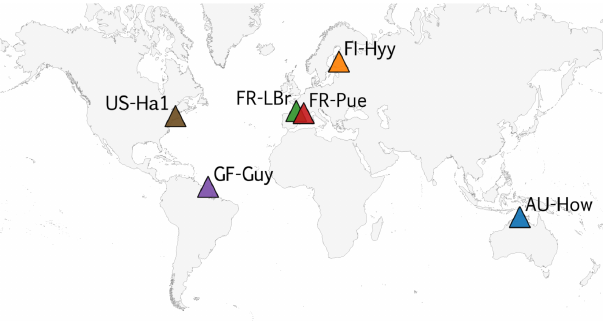
Figure C1. Map of FLUXNET sites used in the